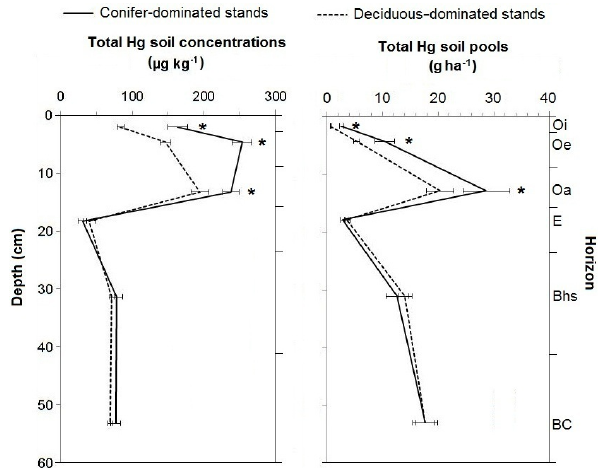
Figure 2. Total Hg (THg) concentrations in organic and mineral horizons at conifer- and deciduous-dominated forest stands. Mean values are given ± 1 standard error. An asterisk indicates a signifi- cant difference using two-sample t tests ( P